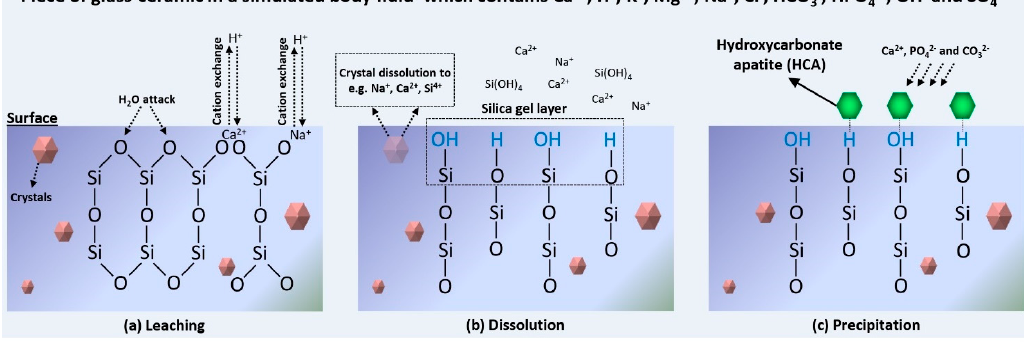
Figure 1. A series of surface chemical reactions including ( a ) leaching, ( b ) dissolution, and ( c ) precipitation occurs after immersion of BGs and glass-ceramics in biological fluids (e.g., plasma